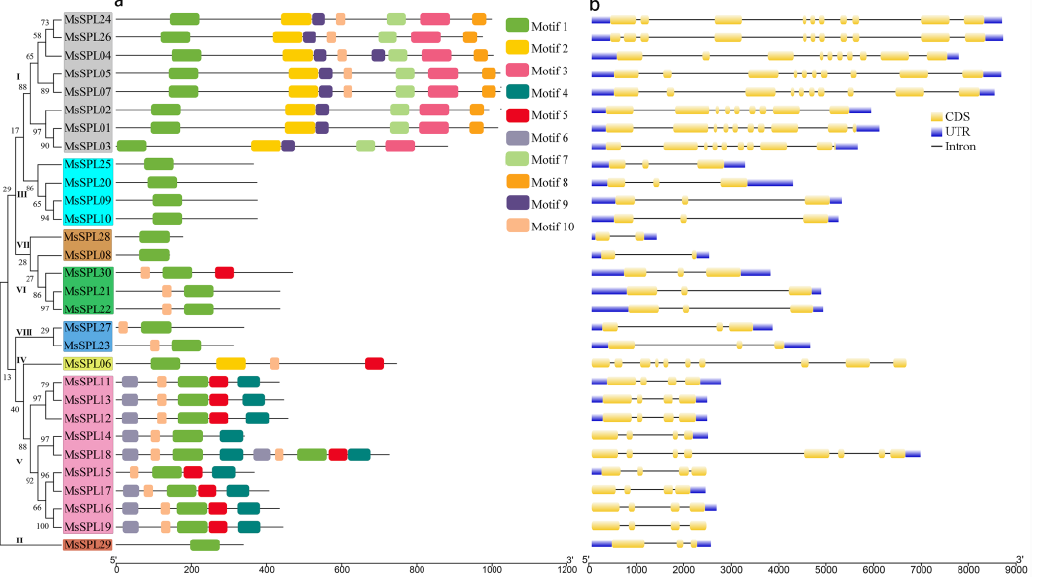
Figure 4. The architectures of the conserved protein motifs ( a ) and gene structures ( b ) of the SPL genes in alfalfa.